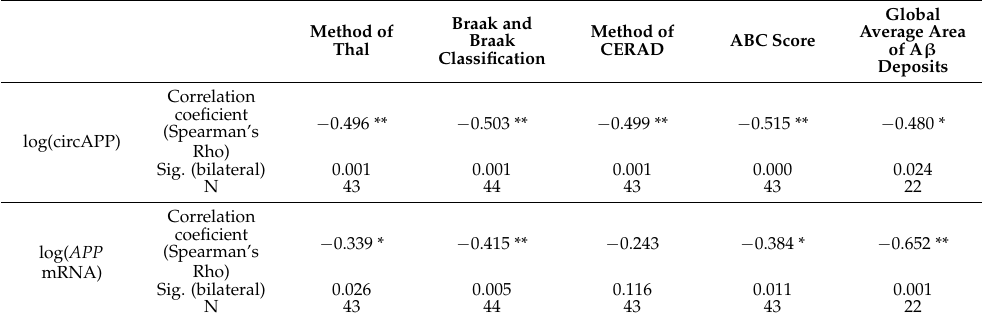
Table 1. Correlation between the Method of Thal, Braak and Braak classification, Method of CERAD, Global average area of A β deposits and circAPP or APP mRNA expression levels.